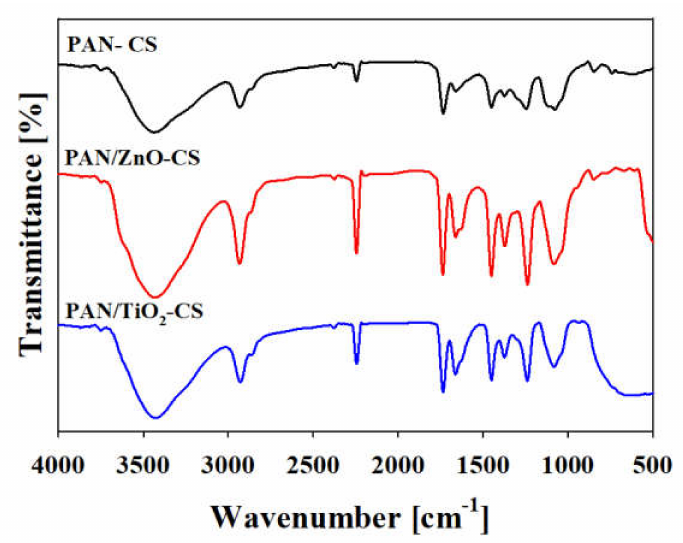
Figure 3. FTIR analysis of the bilayer